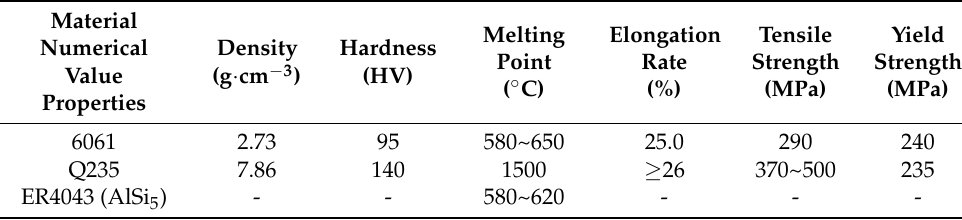
Table 4. Physical properties and mechanical behavior of 6061 aluminum alloy, Q235 galvanized steel, and ER4043 welding wire [16].